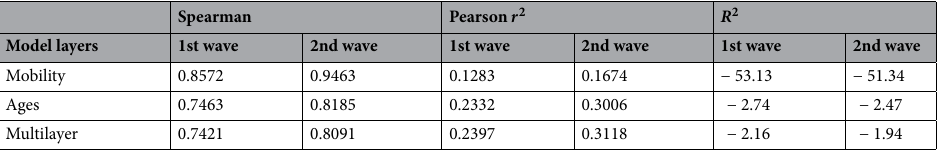
Table 2. Relevance of the different layers of information in the model for the first and second pandemic waves analyzed using different correlation parameters.